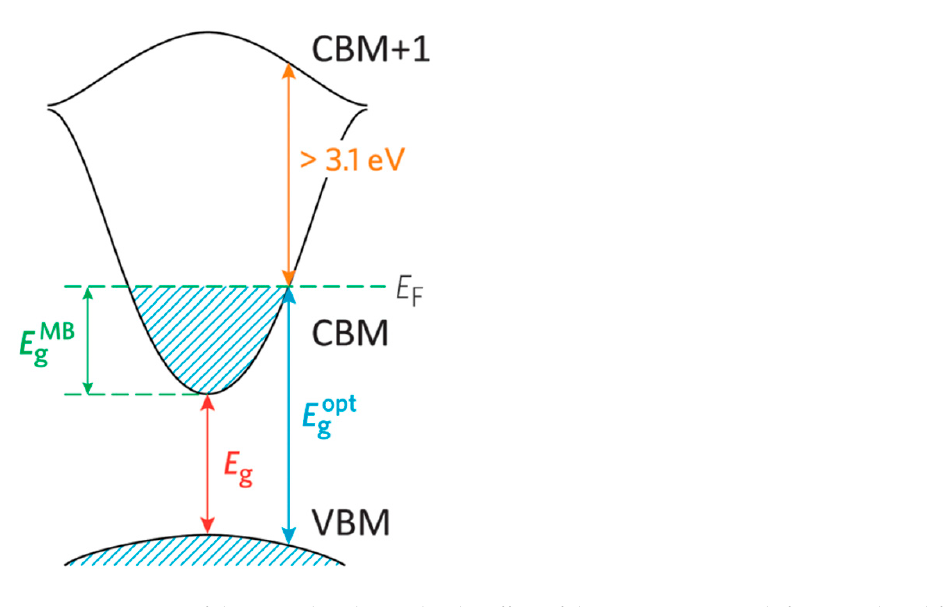
Figure 1. Diagram of the optical widening by the effect of the Moss–Burstein shift. Reproduced from Ref. [6], an open access article.